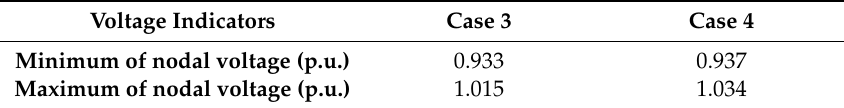
Table 5. Voltage characteristics of nodal voltage of di ff erent